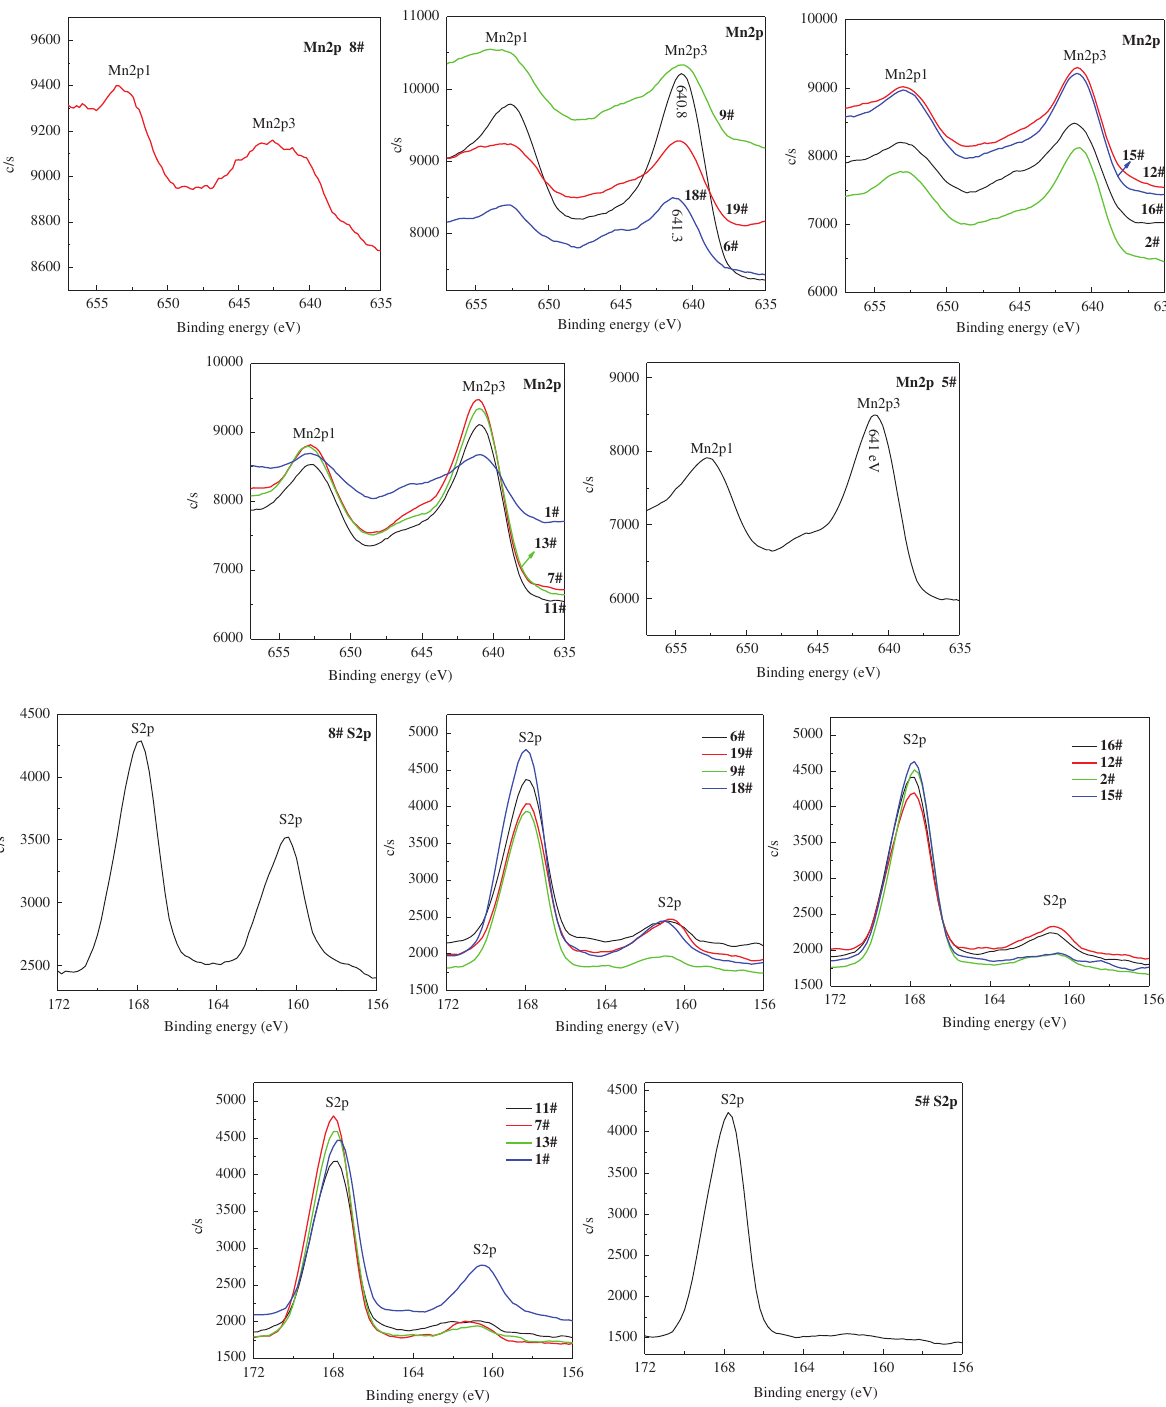
Figure 7: XPS detail spectra of S and Mn in zinc calcine with different MnO 2